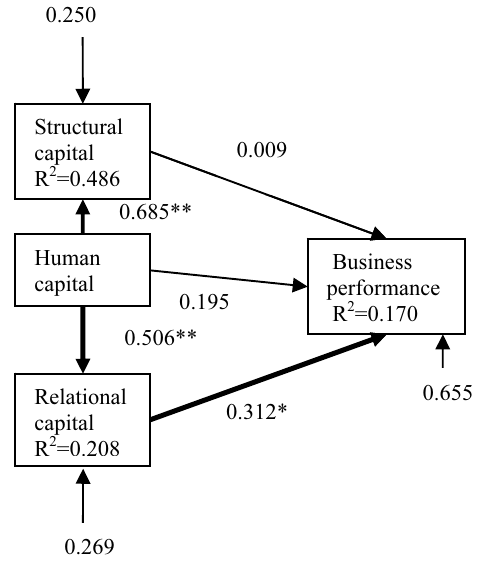
Fig 2. Path model after analysis. *p ＜ 0.05; **p ＜